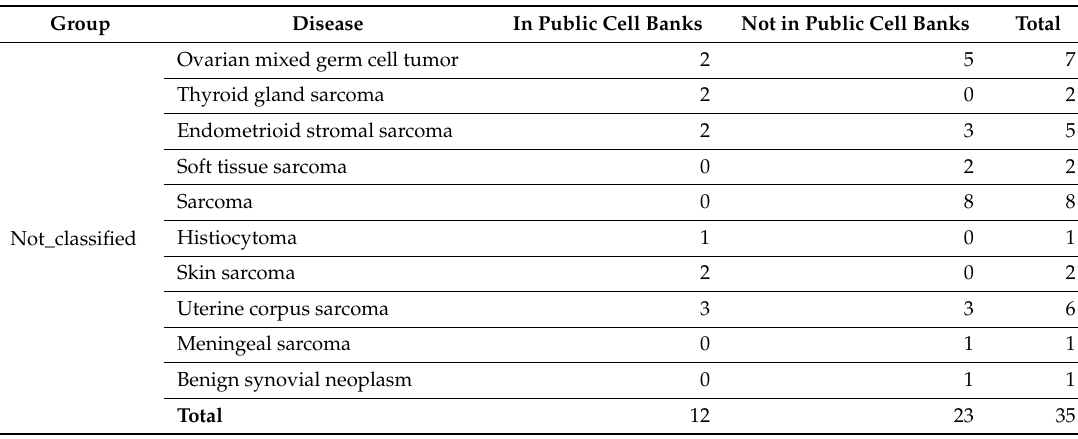
Table 3. Availability of cell lines with histology unclassified by